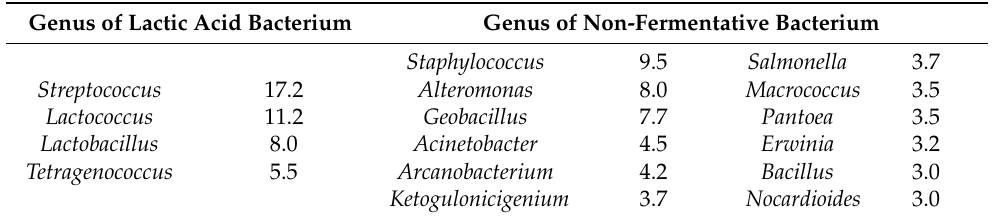
Table 3. Relative abundance (%) of the bacterial community in whey during spontaneous lactic acid fermentation at the genus level.